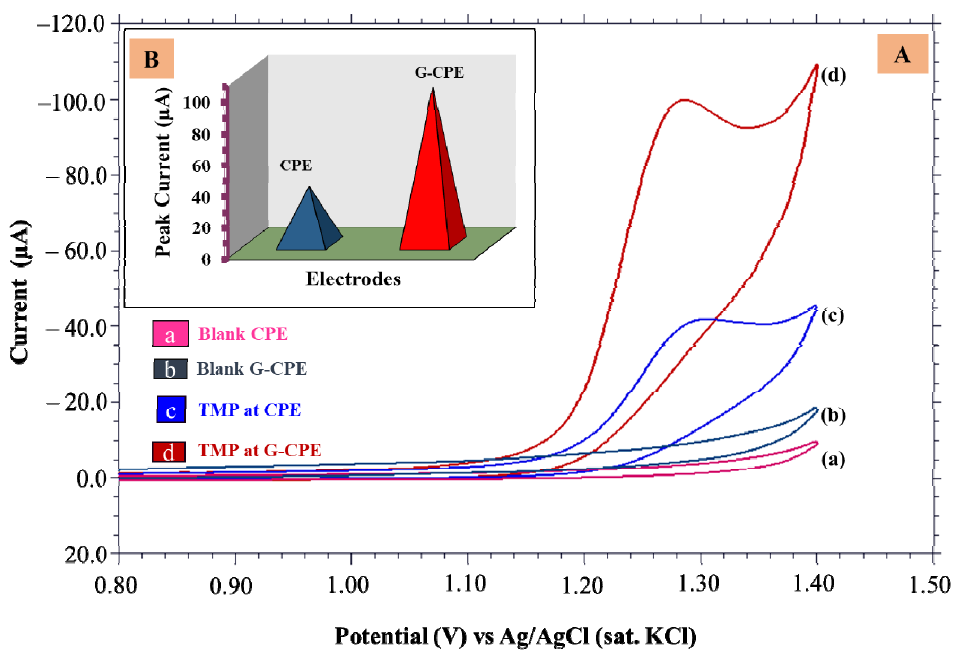
Figure 2. ( A ) Cyclic voltammograms of ( a ) blank CPE, ( b ) blank G-CPE for buffer solution, ( c ) nascent CPE, and ( d ) G-CPE for 0.5 mM TMP solution, ( B ) Peak current responses at fabricated electrodes.